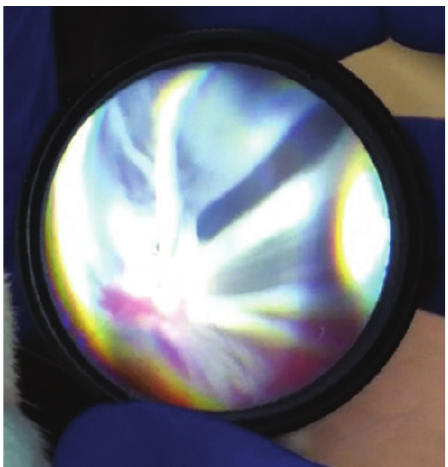
Figure 8: Experimental rabbit eye with induced total retinal detachment and severe proliferative